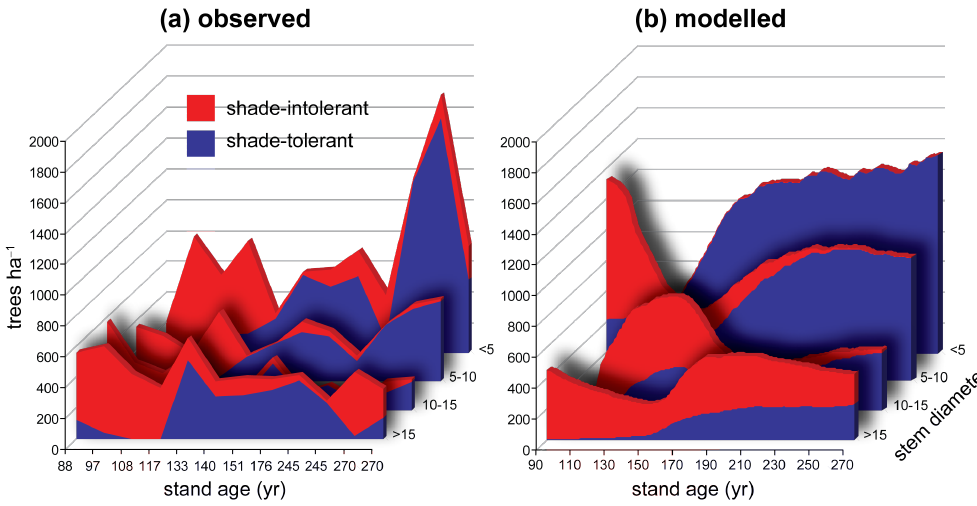
Fig. 4. Size structure and generalised composition of boreal forest stands along a chronosequence constructed by ranking 12 virgin forest stands in northern Sweden in order of age. (a) Observed data modified from Linder et al. (1997); (b) average for corresponding locations simulated under repeated 1961–1990 climate. Shade-intolerant=aggregated data for Betula spp., other deciduous, and Pinus sylvestris ; shade-tolerant= Picea abies . Note: x axis not to scale for (a) ; each tick mark corresponds to a specific stand arranged in rank order of age along the axis.